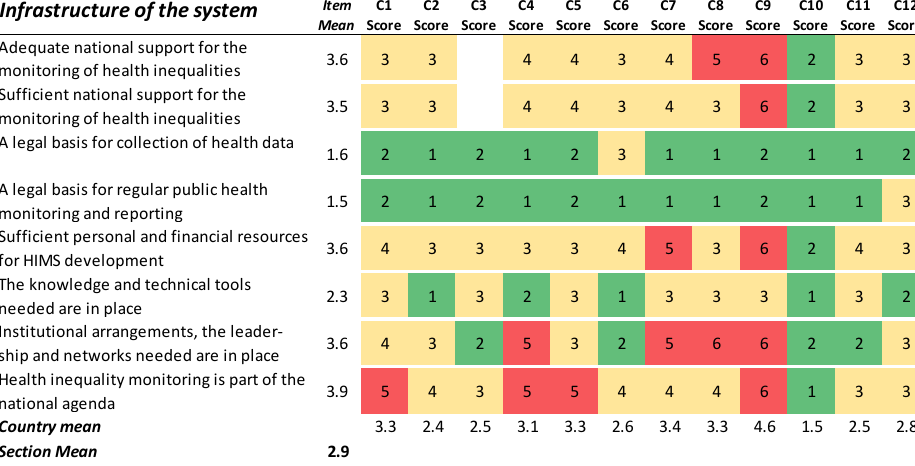
Figure 6. Results for the section ‘Infrastructure of the system’. Green cells (scores 1–2) indicate agreement with the statement. Yellow cells (scores 3–4) indicate partial agreement/disagreement, and red cells (scores 5–6) indicate the most challenging preconditions for an ideal HIMS.